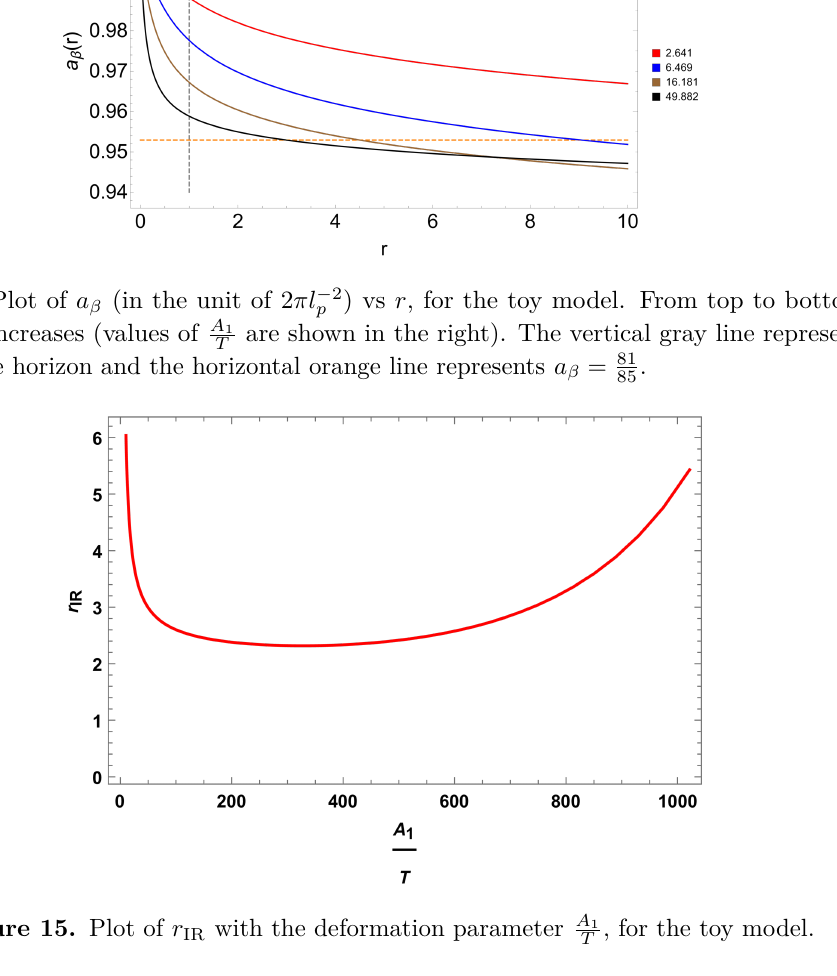
Figure 15. Plot of r IR with the deformation parameter A 1